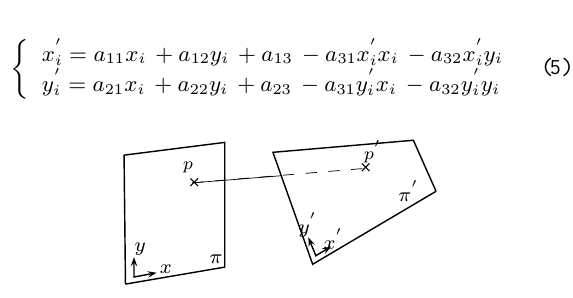
Figure 7: Example of projective